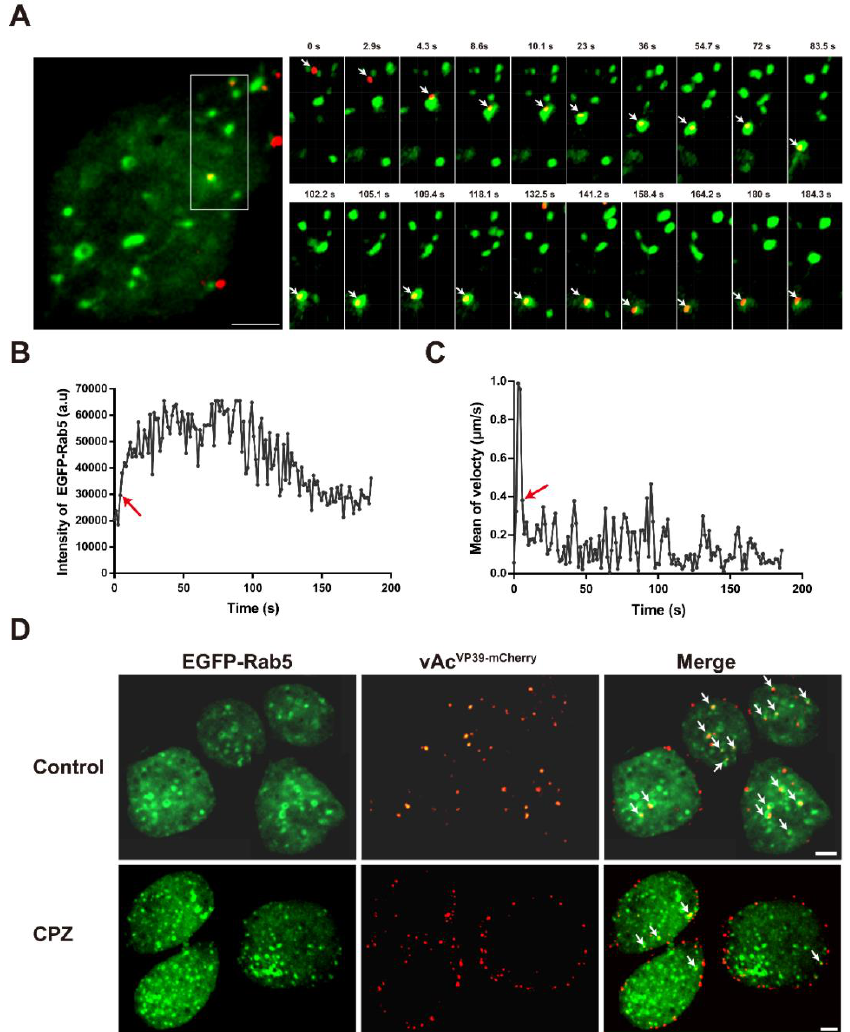
Figure 3. Depolymerization of CPPs inhibits the delivery of AcMNPV particles into early endosomes. ( A ) A representative example of a virus particle (vAc VP39-mCherry , red) delivered to an early endosome (Sf EGFP-Rab5 , green). Left panel: Fluorescent image of an EGFP-Rab5-expressing cell infected with mCherry-labeled virus particles. The boxed region of the cell was magnified and shown on the right. Scale bar is 5 mm. Right panel: Selected frames from a virus particle (vAc VP39-mCherry , red) delivered to an early endosome (EGFP-Rab5, green). The virus particle is indicated with an arrow. ( B ) Time trajectories of the fluorescence intensity of EGFP-Rab5 colocalized with the virus particle. Immediately after being delivered to an early endosome, the fluorescence intensity of EGFP-Rab5 suddenly increased (indicated with an arrow). Subsequently, the intensity of EGFP-Rab5 colocalized with the virus particle continued to increase, indicating that the virus-bearing early endosome underwent fusion to mature. Thereafter, the fluorescence intensity of EGFP-Rab5 decreased gradually, indicating that the virus particle was gradually released from the early endosome. ( C ) Time trajectories of the mean velocity of the virus particle. The virus particle underwent rapid movement until being delivered to an early endosome. After delivery to the early endosome, the mean velocity of the virus-bearing endosome was remarkably reduced (indicated with an arrow). ( D ) Representative images of EGFP-Rab5 endosomes (green) and virus particles (red) in live untreated and CPZ-treated cells. For the CPZ-treated group, cells (Sf EGFP-LCa ) were pre-treated with CPZ for 0.5 h at 27 °C, and were then incubated with vAc VP39-mCherry (MOI = 50) for 0.5 h at 4 °C. The temperature was then raised to 27 °C. Images were captured as snapshots 20 min after infection. The virus particles that colocalized with early endosomes are marked by arrows. Scale bar: 5 µm.